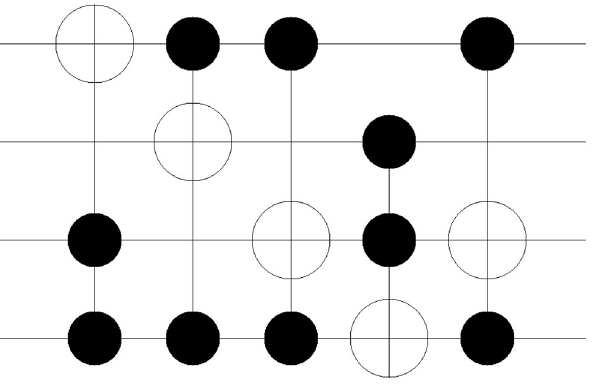
Fig 11. Resulting circuits of No. 18 mini_alu with varying N